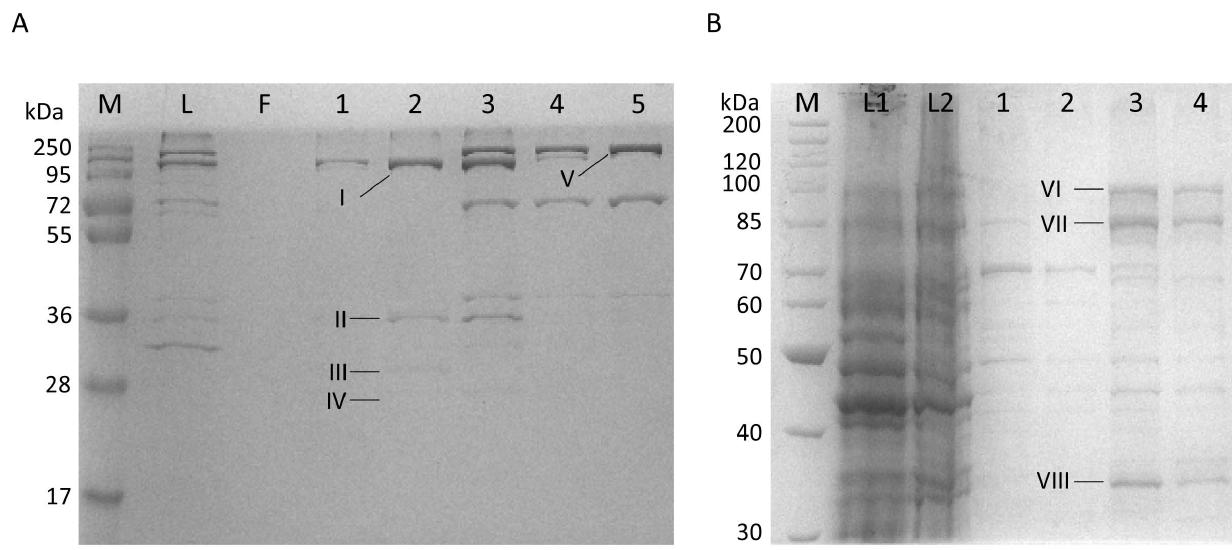
Figure 1. SDS-PAGE of the purification step by anion exchange chromatography (MonoQ 5/50 GL column). (A) Protein purification from MC4100 cells cultivated in TGYEP medium supplemented with 2 m M sodium selenite and 2 m M sodium molybdate; 12% (w/v) resolving gel; M: molecular weight marker; L: sample applied to the column; F, column flow-through; 1–5: elution fractions. (B) Protein purification from MC4100 cells cultivated in TGYEP medium supplemented with 100 m M sodium selenite and 100 m M sodium molybdate; 8% (w/v) resolving gel; M: molecular weight marker; L1: sample loaded on the size exclusion column; L2:sample loaded on the anion exchange column; 1–4: elution fractions from the anion-exchange column. Polypeptides labeled I though VIII were those identified by mass spectrometry and are listed in Table 1.